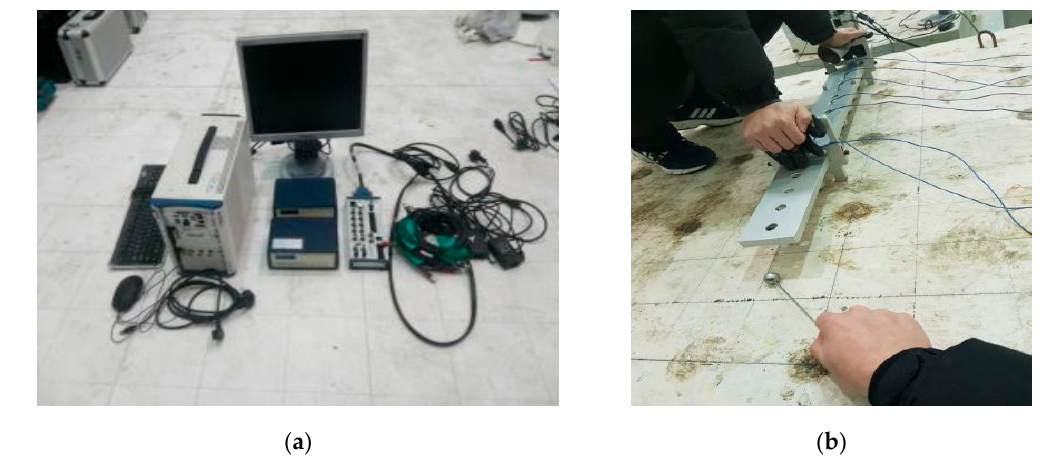
Figure 4. Test method for the multi-channel analysis surface wave (MASW). ( a ) Composition of test equipment; ( b ) Sensor placement for MASW test.